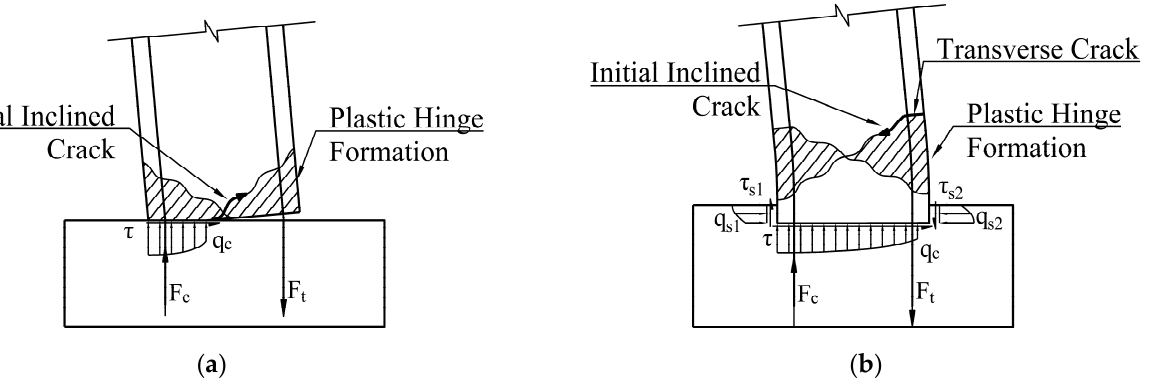
Figure 11. Schematic diagram about force transferring and hinge formation in the pier ( a ) with initial horizontal defect; ( b ) without initial horizontal defect.